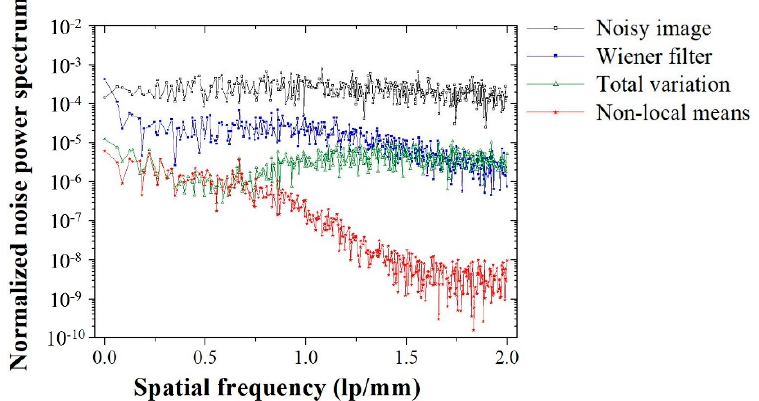
Figure 10. Normalized noise power spectrum (using the ROI A in Figure 9) obtained by applying the different denoising methods to images that were acquired of the 50 mm Pb plate phantom with IQI penetrameters.